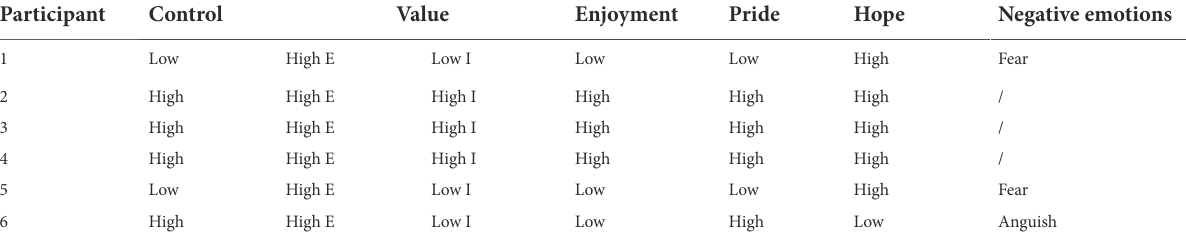
TABLE 3 Participants’ control-value appraisals and achievement